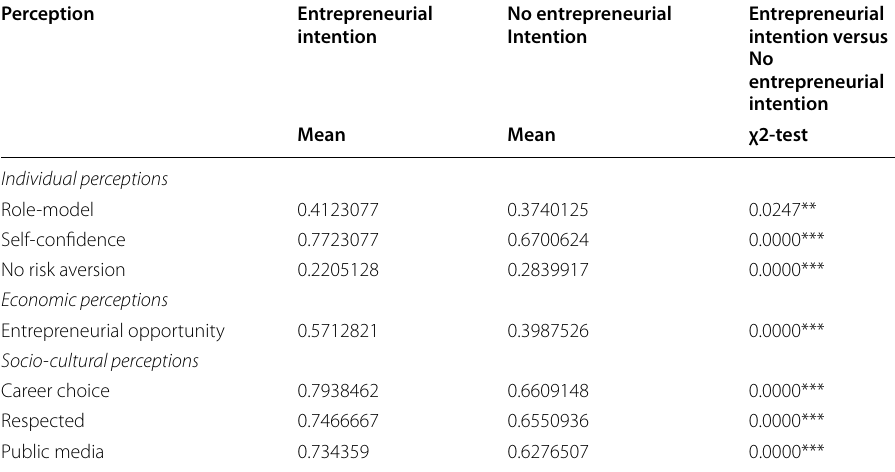
Table 5 Perceptions and entrepreneurial